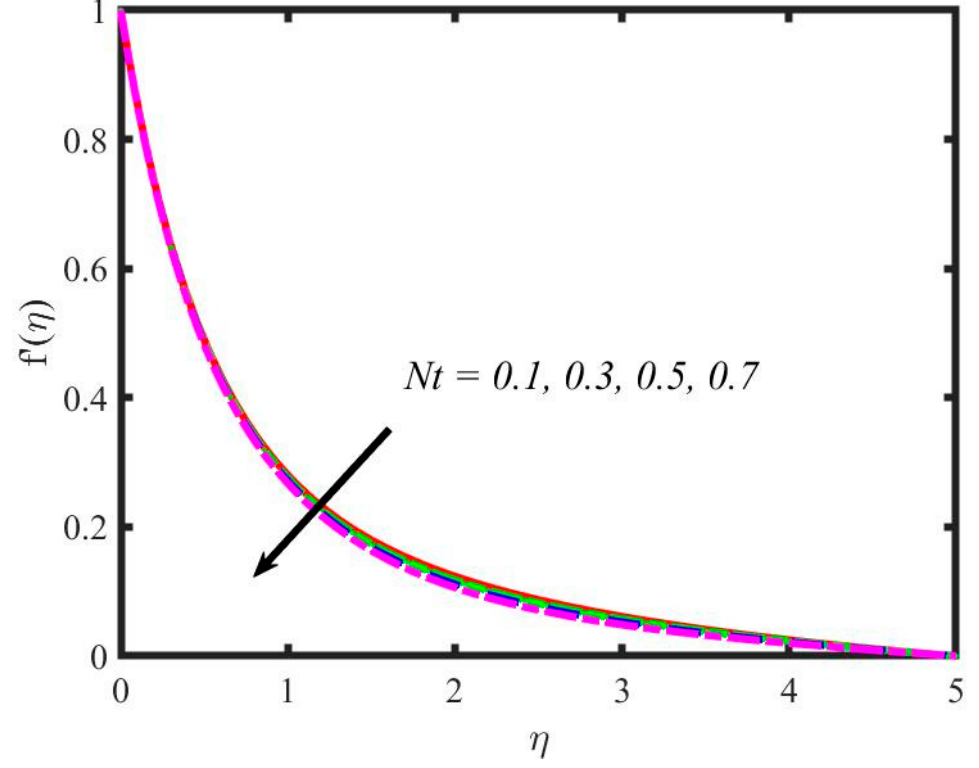
Figure 7. Variations in velocity for thermophoresis parameter.